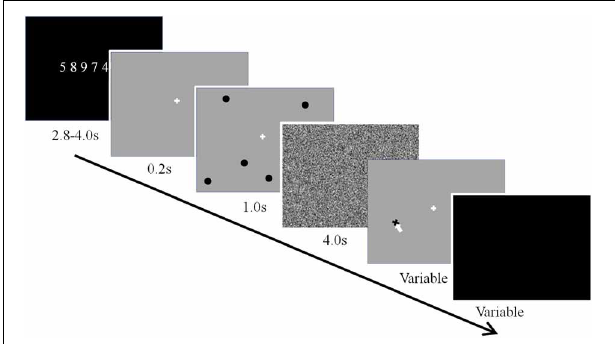
FIGURE 3 | Dual verbal-spatial working memory task.